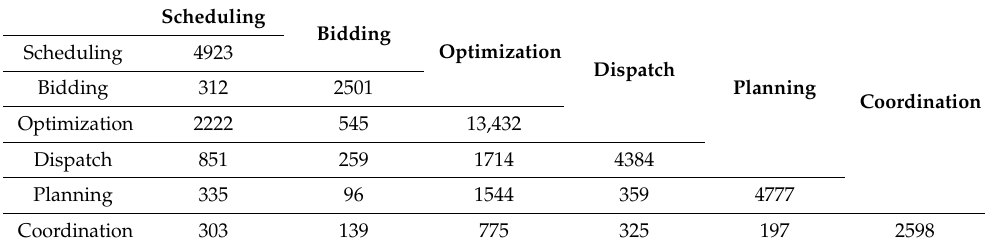
Table 2. Total number of works in each group (diagonal value) and overlaps between the groups (extra-diagonal value).